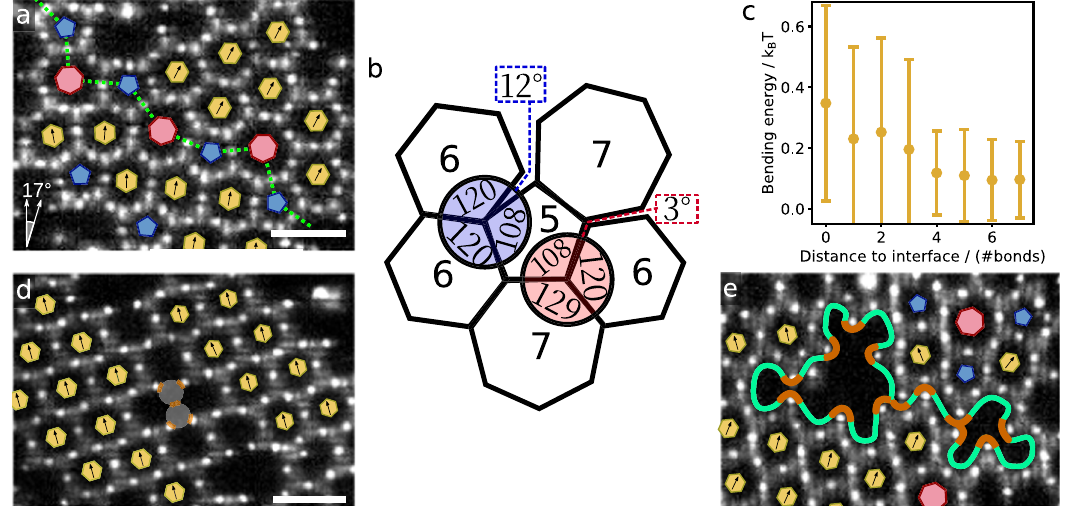
Fig. 2 | Defects in colloidal graphene. a Confocal microscope image of a typical grain boundary consisting of pentagons and heptagons. Green dotted boundary separatesgrainsrotatedby θ ~17 ∘ withrespecttoeachother(leftlowerinset),which matches observations in atomic graphene 64 . b Schematic indicating the compat- ibility of 5-, 6- and 7-membered rings. Two 6-membered rings and a 5-membered ring leave a 12 ∘ angular mismatch, while a combination of one 5-, one 6-, and one 7-membered ring leaves a mismatch of only 3.4 ∘ . c Bond bending energy as a function of distance (in terms of the number of bonds) awayfrom theboundaryin a . Variances indicate the standard deviation of the energy distribution, which is